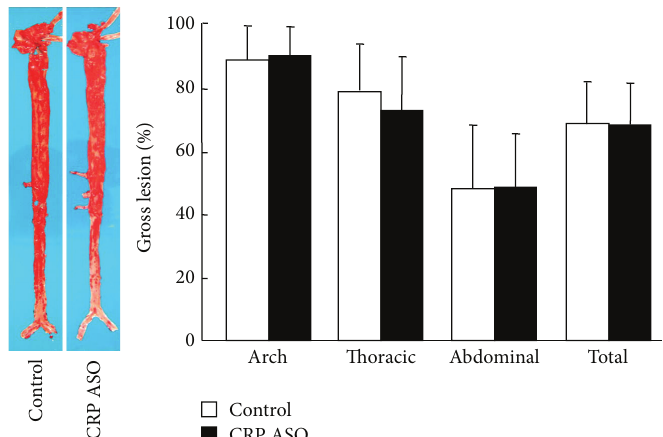
Figure 4: Analysis of aortic lesions. Representative photographs of pinned-out aortic trees stained with Sudan IV from CRP ASO-treated and control rabbits are shown (left), and aortic atherosclerotic lesions (defined by sudanophilic area) on the surface were quantified with an image analysis system (right). 𝑛 = 9 for each